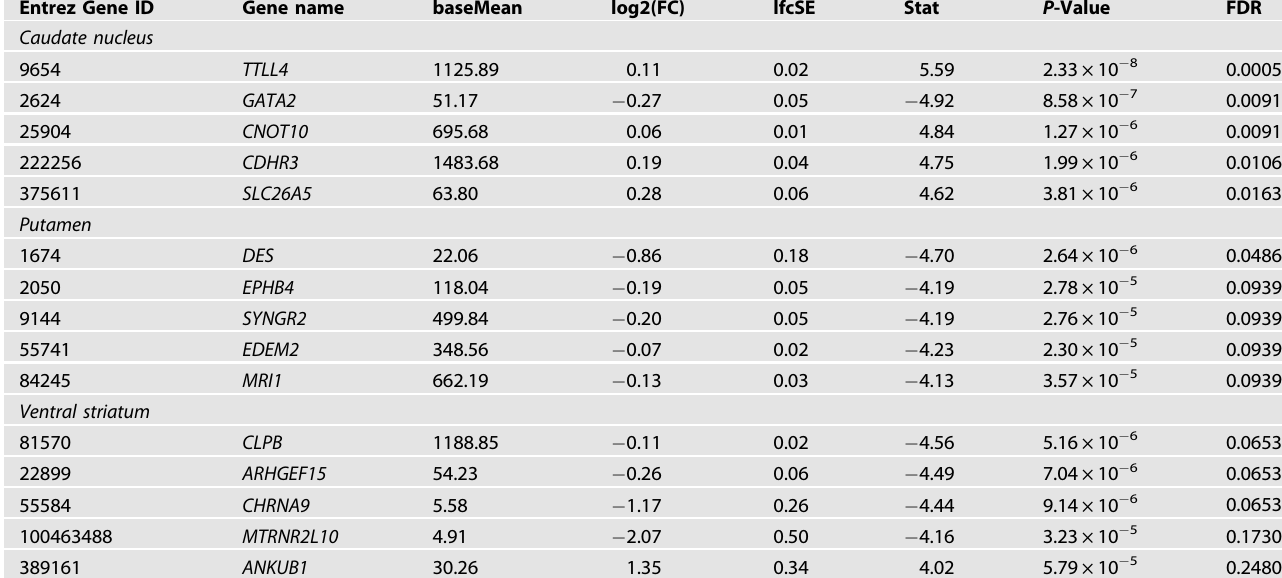
Table 2. Top 5 differentially expressed genes in caudate nucleus, putamen, and ventral striatum. Entrez Gene